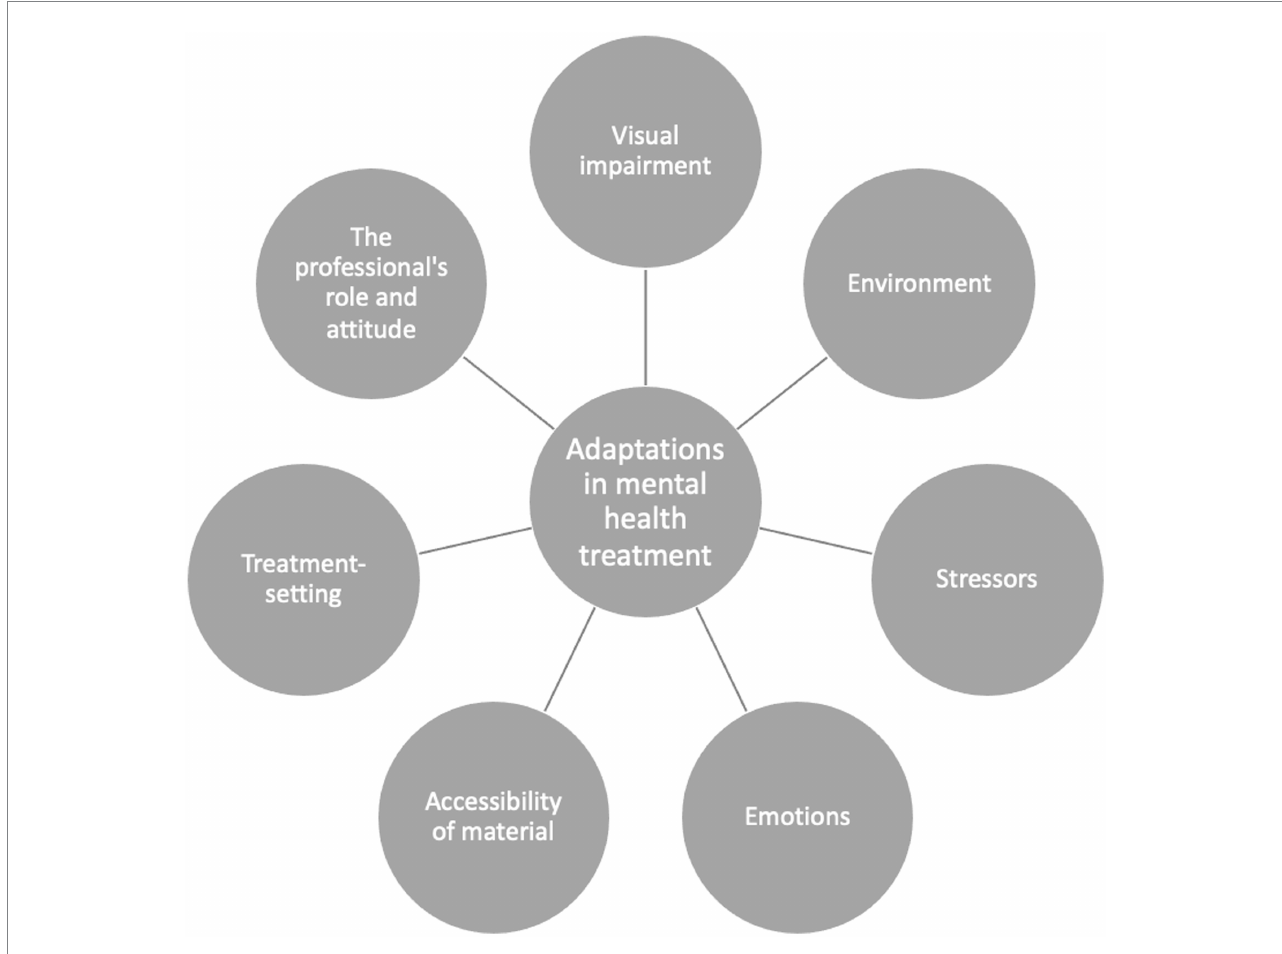
FIGURE 1 Overview of the categories related to the needed required adaptations in mental health